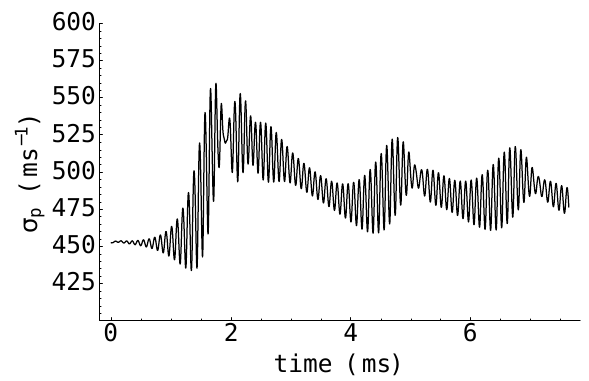
FIG. 14. Energy spread of a 200 mA fully stretched unstable bunch as a function of time. The ring impedance consists of main-cavity and harmonic-cavity fundamental rf modes realisti- cally detuned for beam-loading compensation. Machine param- eters are given in Table I.